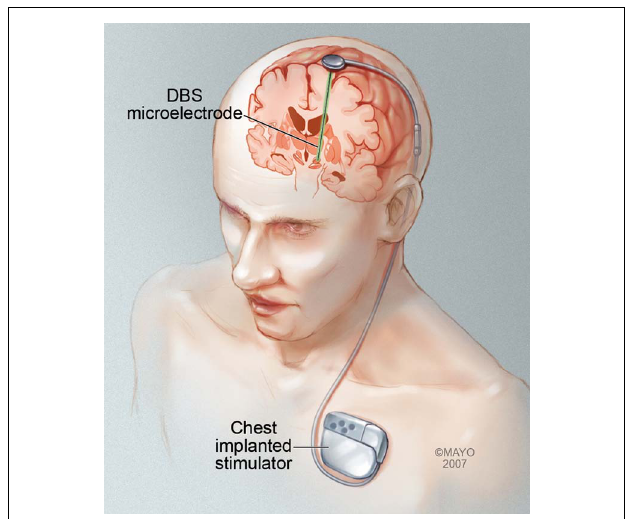
FIGURE 1 | Illustration of a DBS system with a microelectrode implanted deep within the brain. This microelectrode is connected to a programmable stimulator/battery that is typically implanted in the chest in the subclavicular space. Permission to use this image granted by Mayo